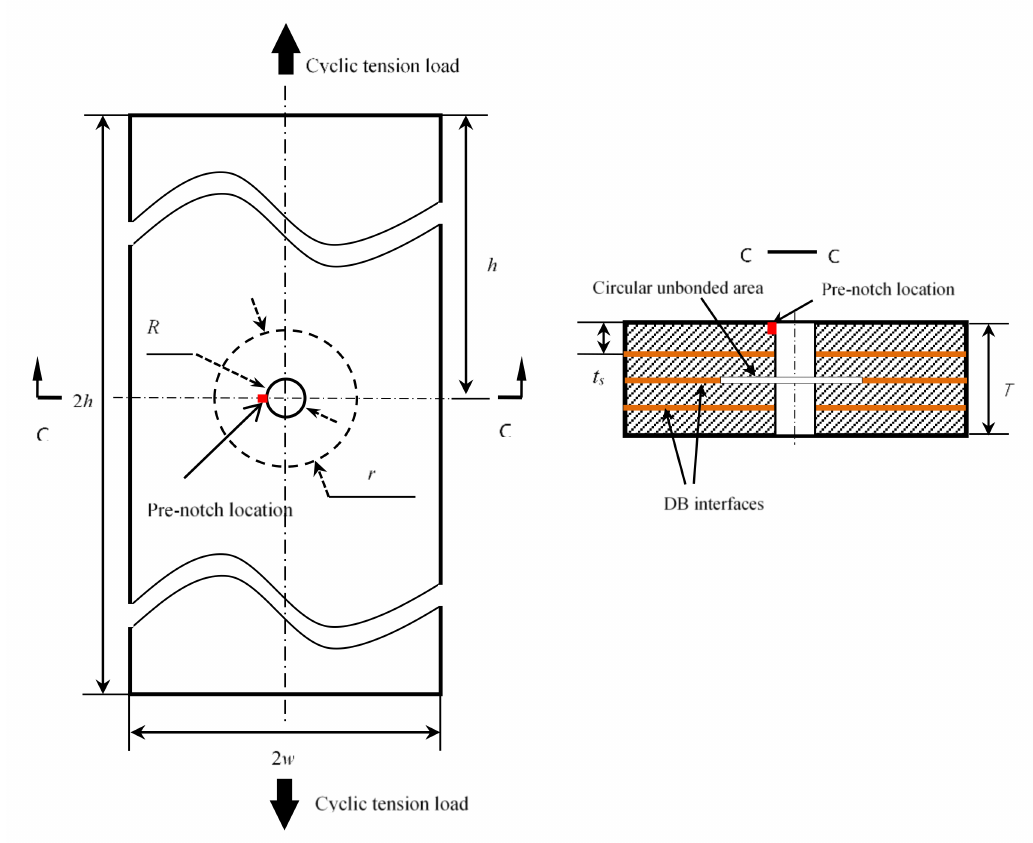
Figure 2. The di ff usion bonding titanium alloy laminates with preset unbonded area (DBTALPUA)